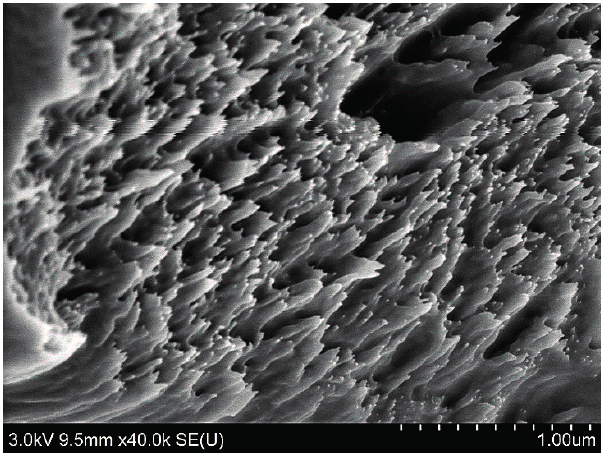
Figure 2. SEM image of the NC 30 film containing 12 wt % (highlighted area in circle Figure 1c) nanocellulose, showing the nanofibres of cellulose embedded inside the gelatine